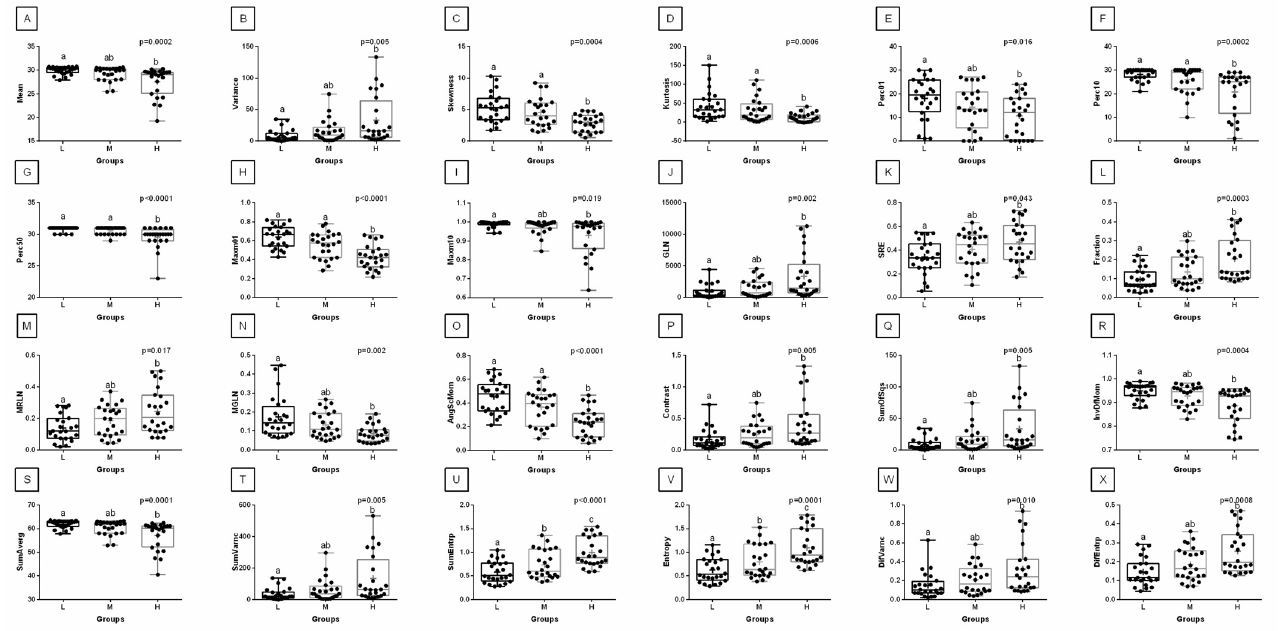
Figure 5. Analysis of texture features for the red component compared between light (L), moder- ate (M), and heavy (H) groups in the first region of interest (ROI 1). Differences between